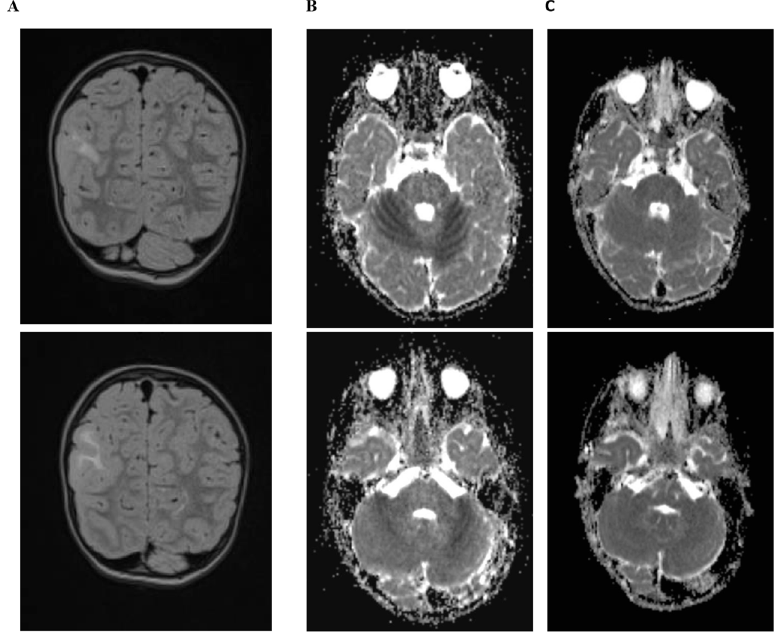
Figure 3. Brain imaging of a girl with bi-allelic variation in PRRT2 (c.649dupC and de novo deletion of 16p11.2) displaying focal cortical dysplasia in the right parietal lobe with preserved upper cortex layers ( A ) on T2-fluid attenuated inversion recovery MRI. After mild head trauma the girl presented with ataxia, problems of expressive language, and myoclonia lasting one to three days. Di ff usion-weighted (ADC, apparent di ff usion coherent) imaging revealed hypointense areas in both cerebellar hemispheres ( B ) that normalized after three weeks ( C ).